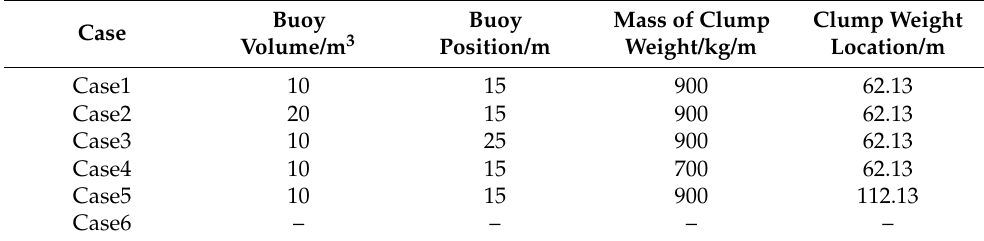
Table 6. Combination scheme of